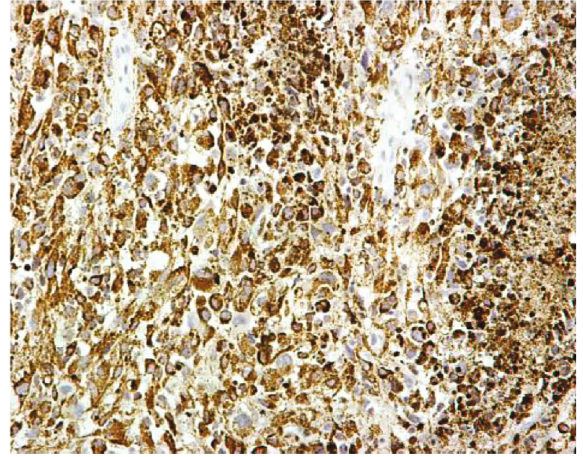
Figure 2: Tumor cells with characteristic melanin pigmentation. Haematoxylin-eosin, × 20 magni fi cation.